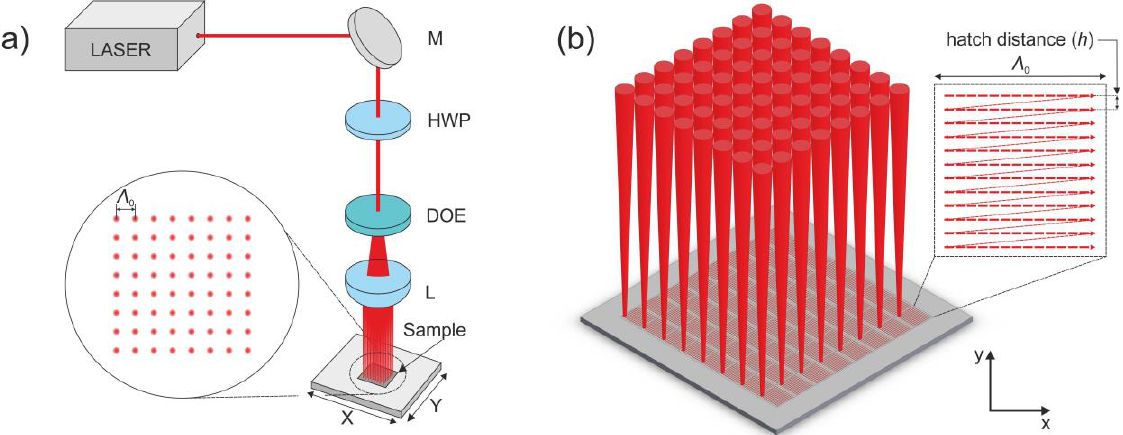
Figure 1. ( a ) Optical setup for the generation of the 8 × 8-beam array. Λ 0 —period of the beam array, M—mirror, HWP—half-wave plate, DOE—diffractive optical element, L—focusing lens. X and Y denote the linear positioning stages. ( b ) Illustration of area scanning using 8 × 8-beam array. Inset is an illustration of unidirectional sequential beam-hatching pattern simultaneously performed for each of 64 beams.